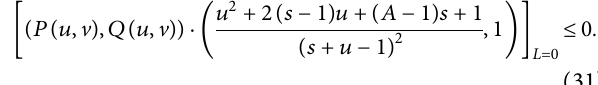
with parameters fixed as s � 2, A � 0 . 5, δ � 1, d � 0 . 25, k k